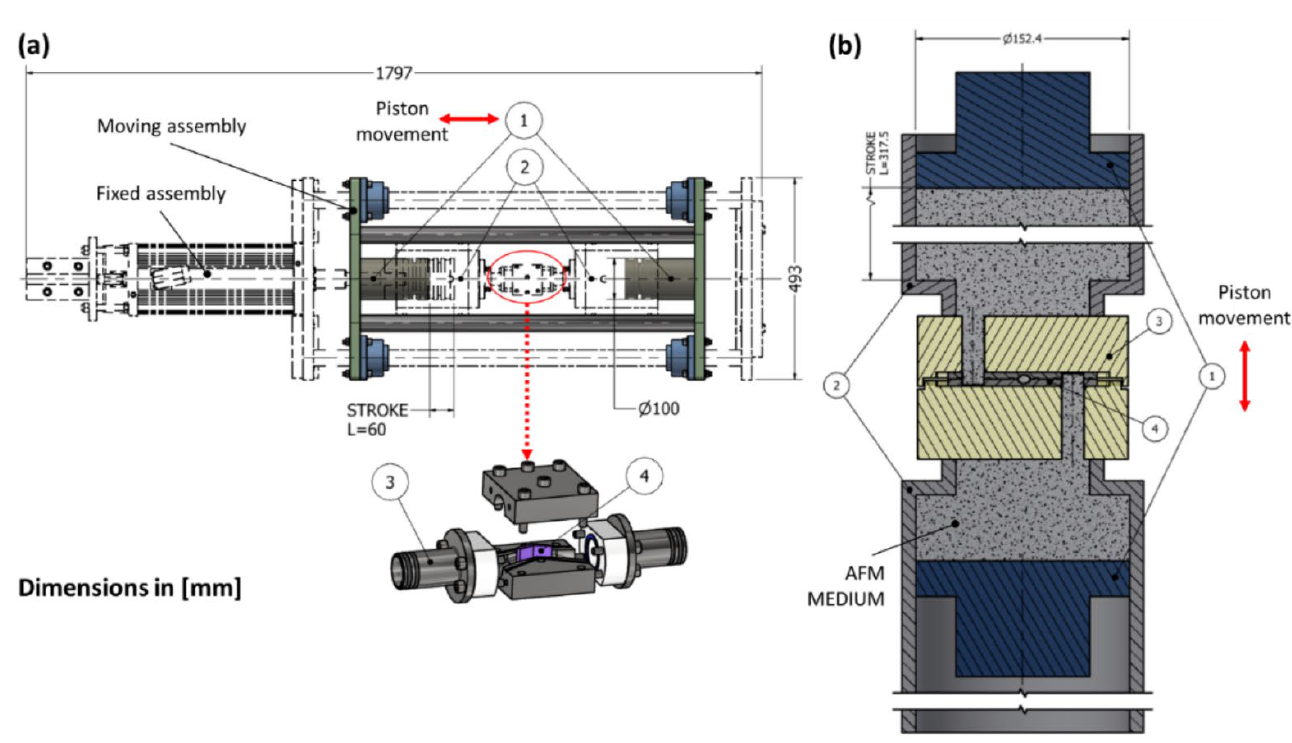
Figure 6. AFM setups: ( a ) V-shape laboratory setup; ( b ) S-shape industrial setup